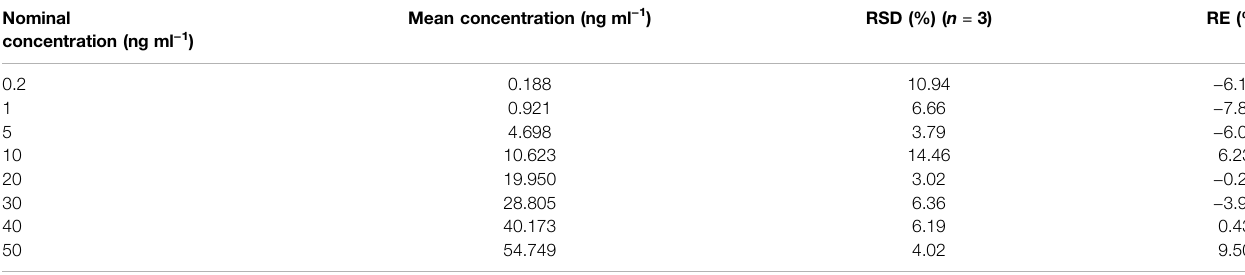
TABLE 1 | Calibration curves from one batch of the validation section.